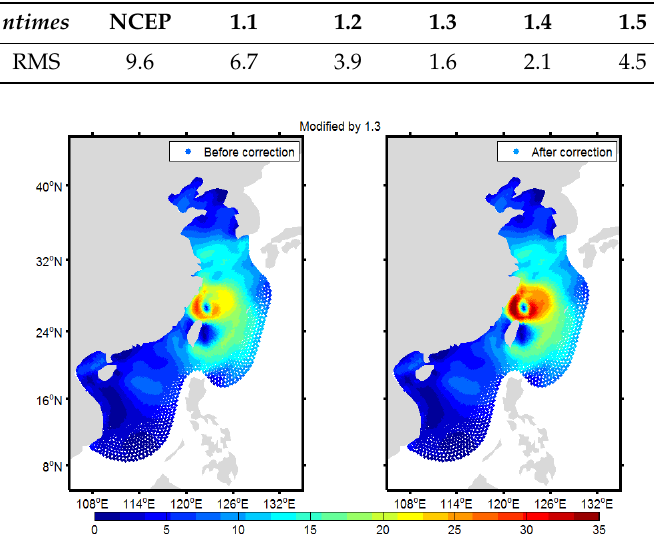
Table 4. RMS difference in maximum wind speed (m/s) between best-track and modified winds from